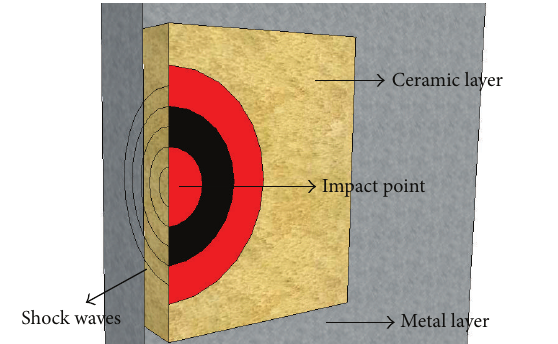
Figure 2: First stage of the impact. The collision generates a shock wave that travels through the